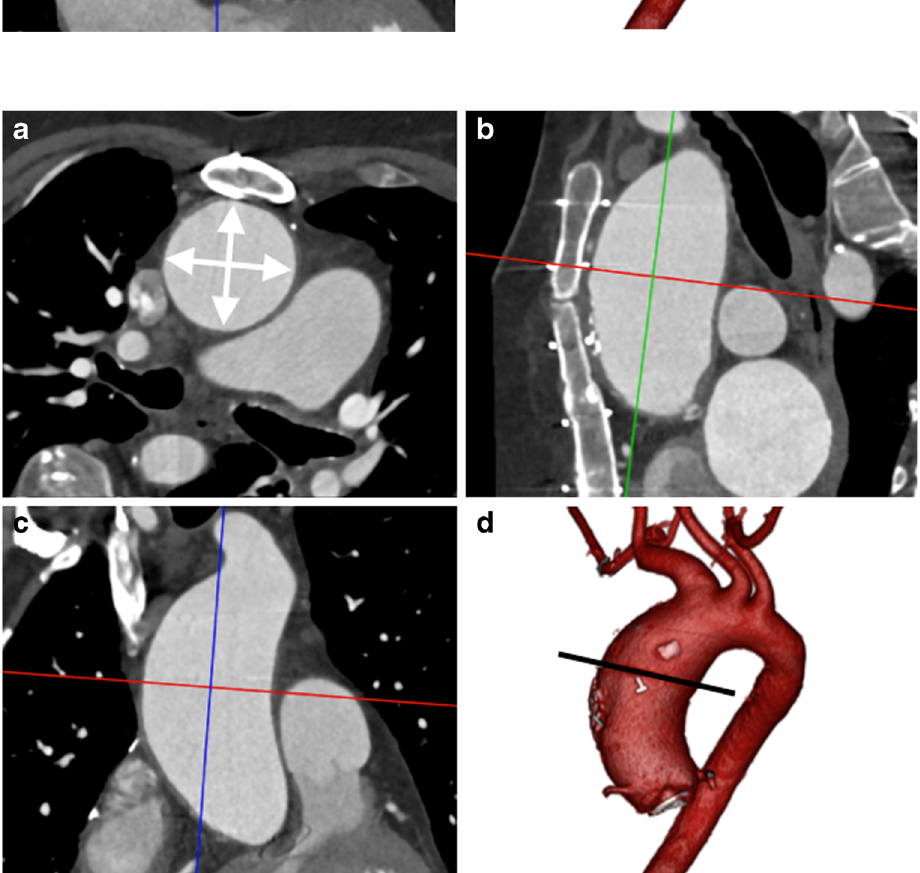
Fig. 1 A 45-year-old man with Marfan ’ s syndrome post aortic valve replacement with a fusiform ascending aortic aneurysm. Measurement of ascending tho- racic aorta dimension ( double arrows ) in an axial plane ( a ) will yield erroneous values due to oblique orientation relative to the centerline of the aorta, as demon- strated on sagittal ( red line , b ) and coronal ( red line , c ) multiplanar reformats (MPRs). Three- dimensional segmented volume rendered (VR) image of the tho- racic aorta ( d ) demonstrates the site of measurement ( line )